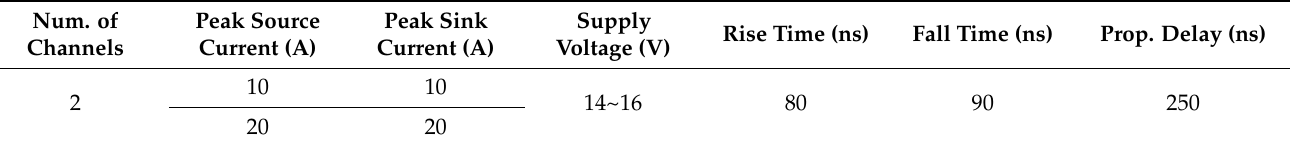
Table 31. Commercial SiC MOSFET drivers by Microchip.